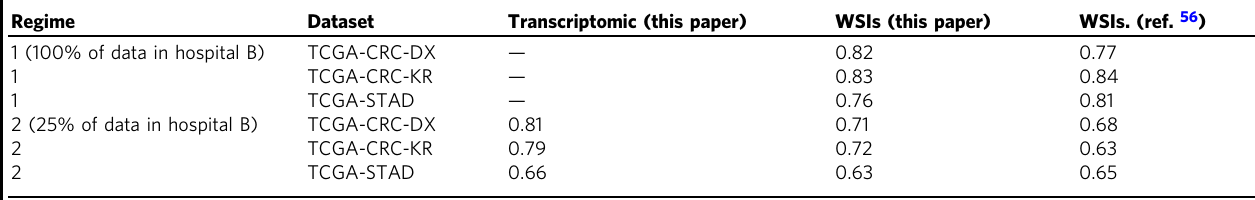
Table 4 ROC-AUCs for the prediction of MSI status in two extreme regimes. Regime